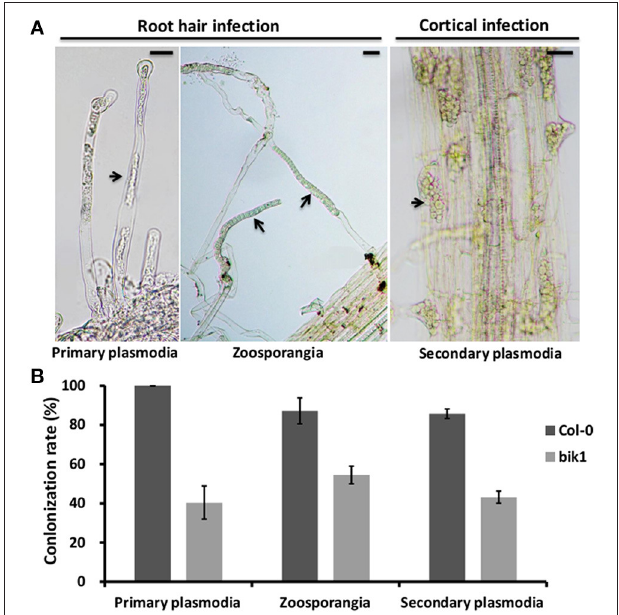
FIGURE 3 | Root hair and cortical infection stages in the roots of Arabidopsis control and bik1 mutant plants. (A) The images show the key steps of P. brassicae infection in Arabidopsis control and bik1 mutant plants, including root hair and cortical infections stages. Primary plasmodia of root hair infection were observed in the roots stained with Nile red for 3 days post inoculation. Zoosporangia of root hair infection and secondary plasmodia of cortical infection were observed in the roots stained with Nile red for 12 days post inoculation. The pictures were under light microscopy. Arrows indicate primary plasmodia, zoosporangia or secondary plasmodia. (B) Mean rate (100%) of primary plasmodia, zoosporangia and secondary plasmodia per root of the control and bik1 mutant. The roots of more than 15 plants were selected for the control and bik1 mutants and sliced into 1–2cm segments. A total of approximately 100 root segments per sample were observed and counted to determine the presence of infection. The error bars represent the SD of the experimental values obtained from three biological replicates. Bar = 10 µ m.